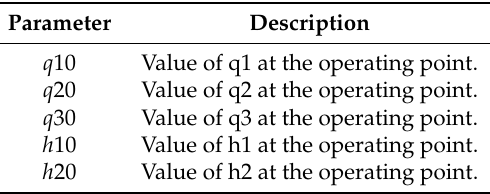
Table A3. Working point.